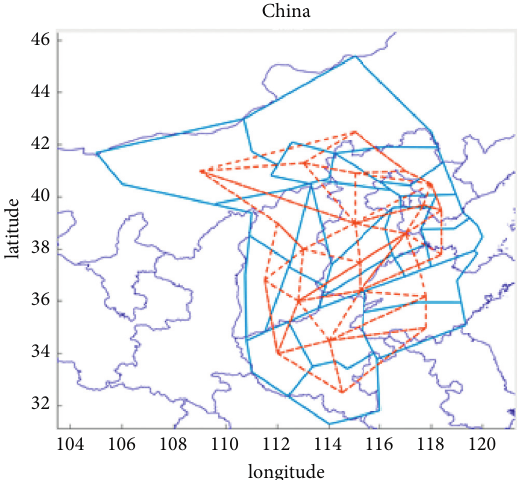
Figure 5: Structure of the North China controlled airspace sector. Figure 6: The North China controlled airspace sector network. Table 1: Statistical characteristics of the North China sector